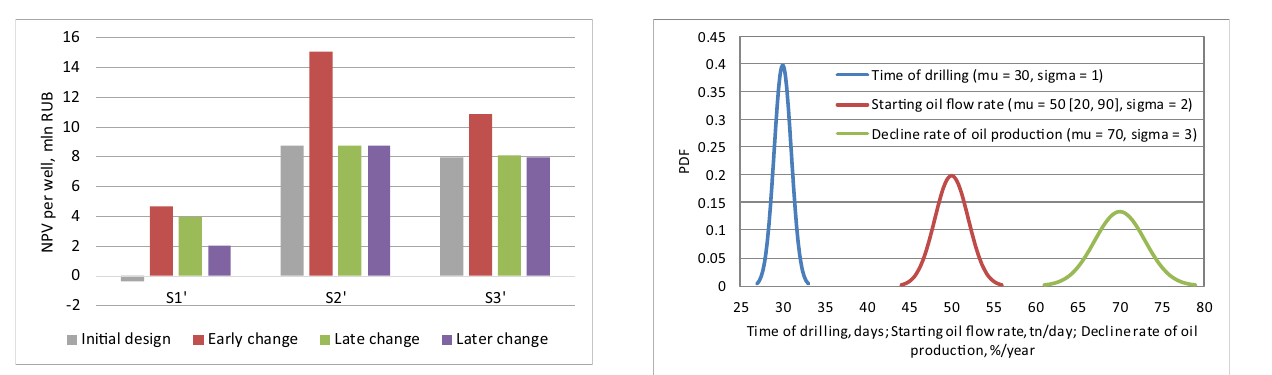
Fig. 14; one parameter—the initial water cut, is distributed